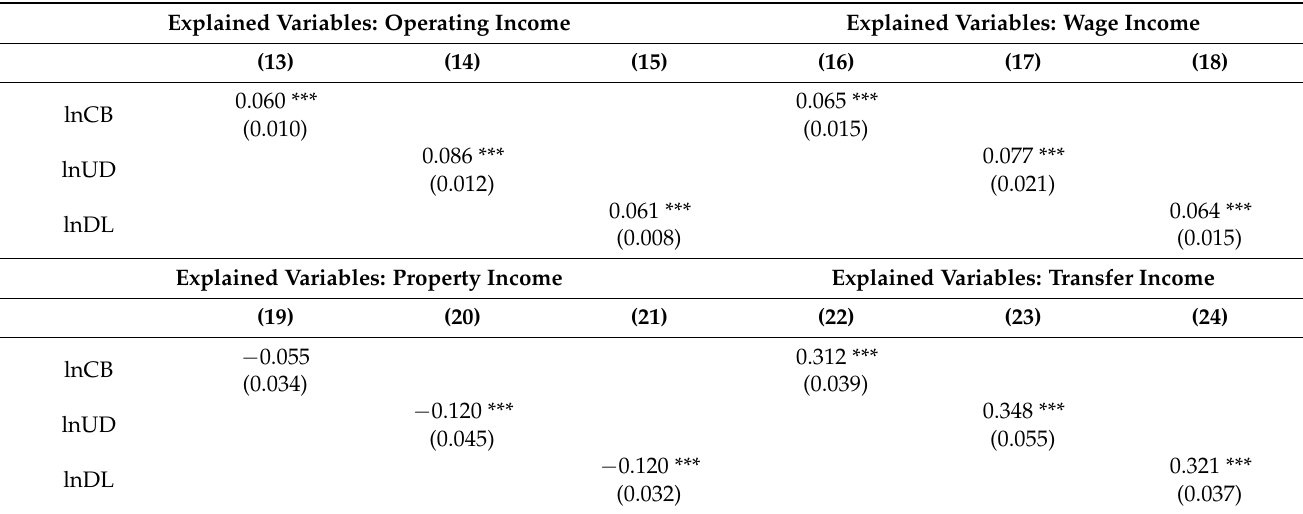
Table 5. Coverage breadth, usage depth, digitization level, and rural resident income